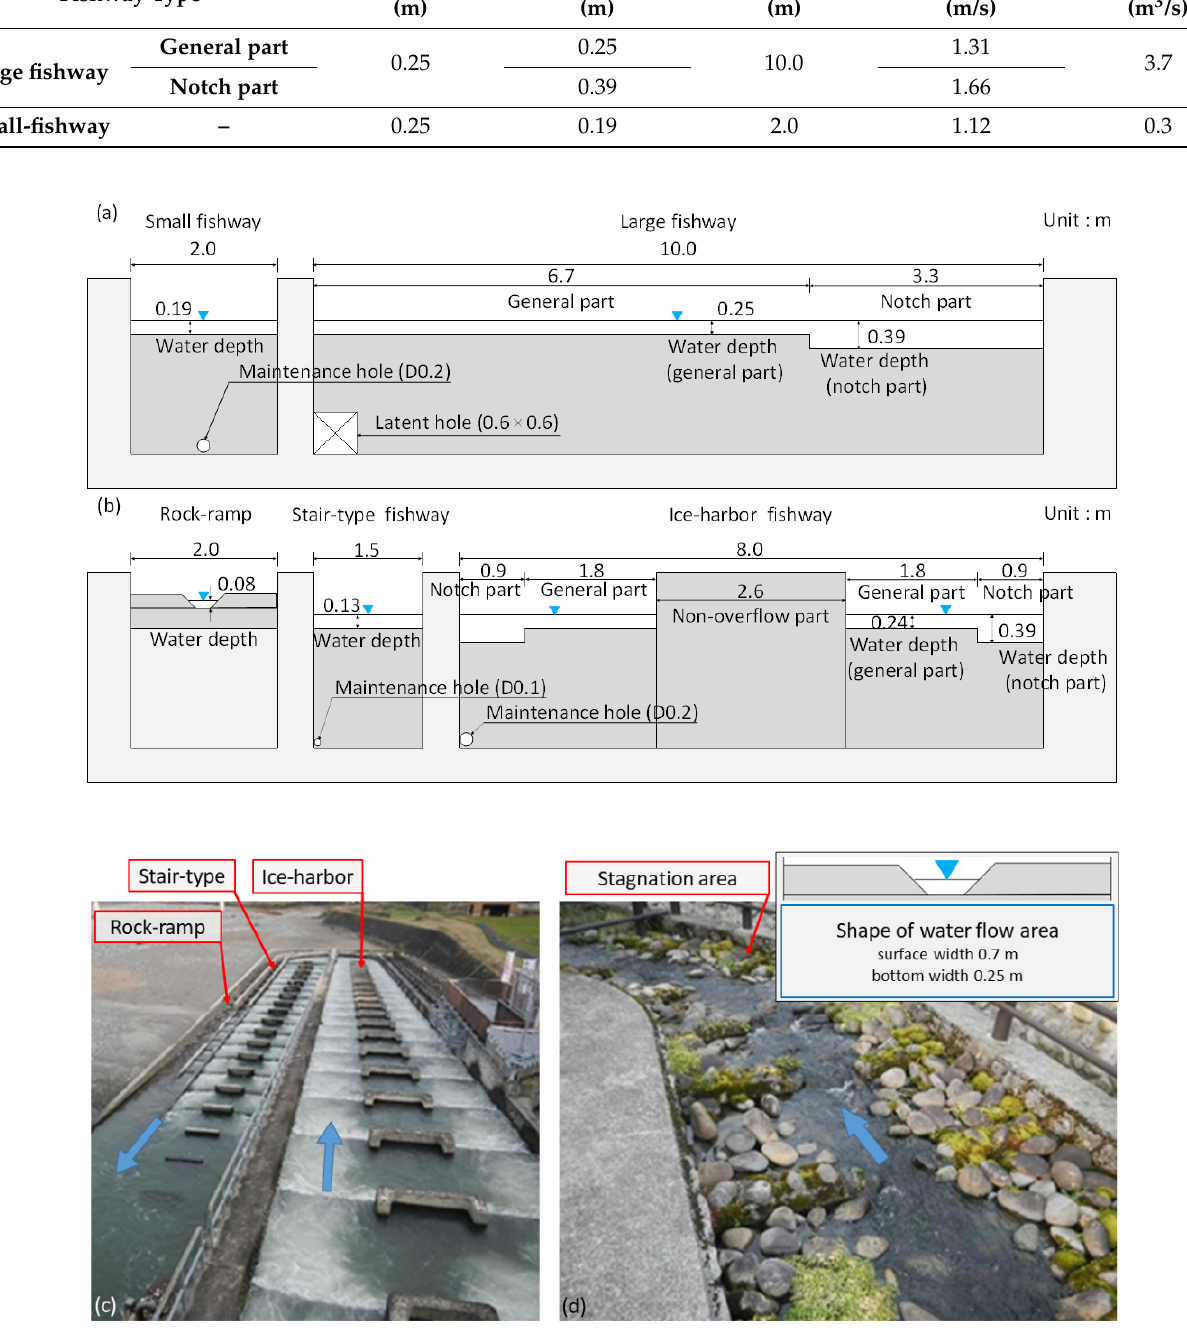
Figure 2. Fishway design ( a ) before and ( b ) after improvements, as seen from the downstream side. ( c ) View of all three fishways (ice-harbor-, stair-, and rock-ramp-type fishways) from the upstream side. ( d ) Rock-ramp fishway; the trapezoidal cross-section contributes to the provision of various